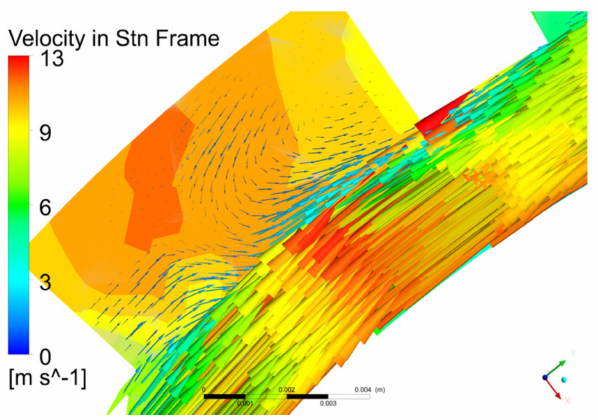
Figure 12. Changes in flow velocity at different pressures on the XY